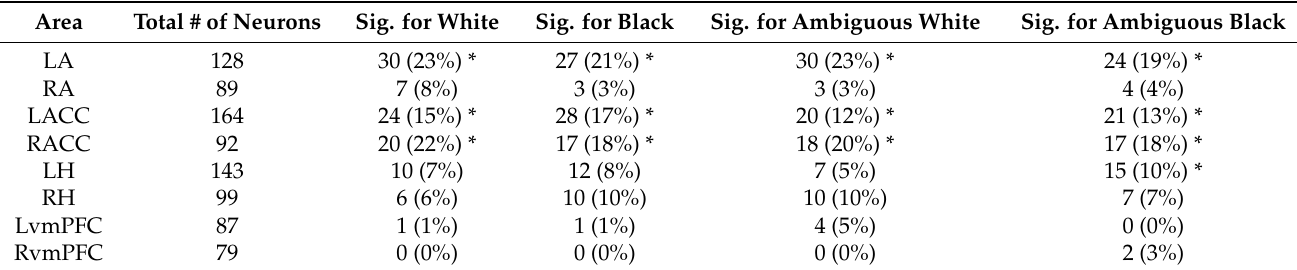
Table A3. Neurons significant for specific race categories (relative to background firing) by side and brain area (SUA), across all patients ( n = 13), as indicated by multinomial logistic regression models. Values with asterisks denote significant proportions in binomial tests ( p < 0.05), after correction for multiple comparisons.